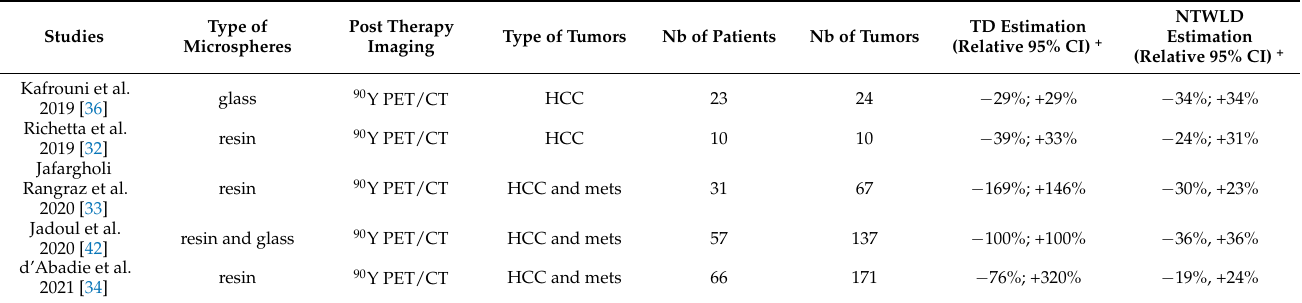
Table 3. Predictive value of pre-therapy MAA imaging for estimating TD and NTWLD (using Bland–Altman analyses for measuring the